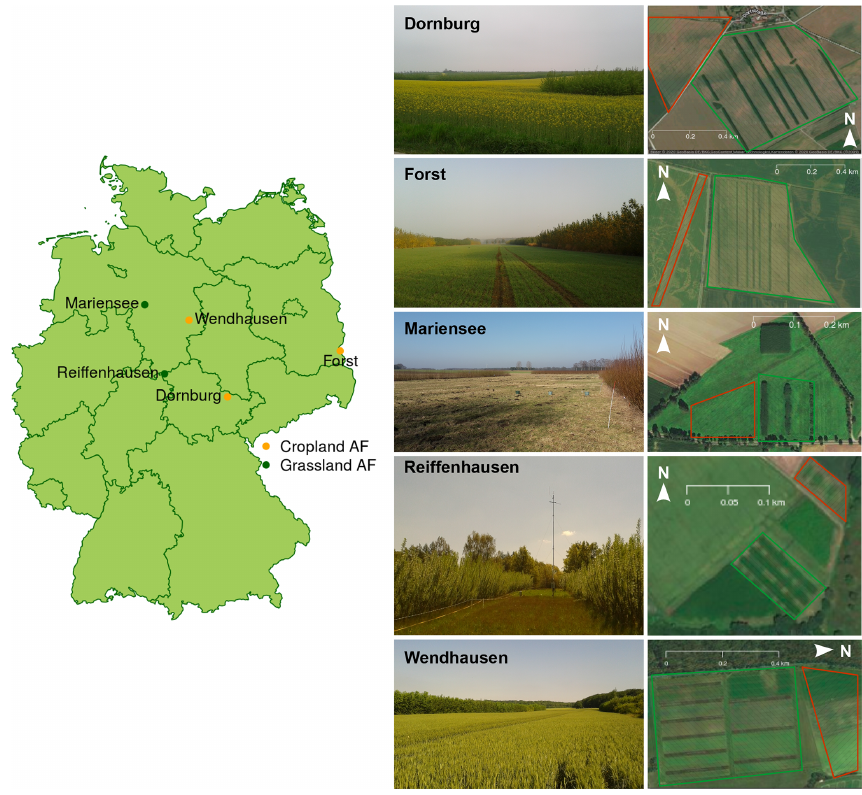
Figure 1. Map of the SIGNAL sites, with the respective agroforestry (AF) system type of either cropland or grassland AF, and an image and aerial photograph of the AF systems. Green hatched areas in the aerial photographs correspond to the area of the AF system, and red hatched areas correspond to the area of the MC system. Site images are our own photographs, and the aerial photographs originate from Google Maps and Google Earth. © Google